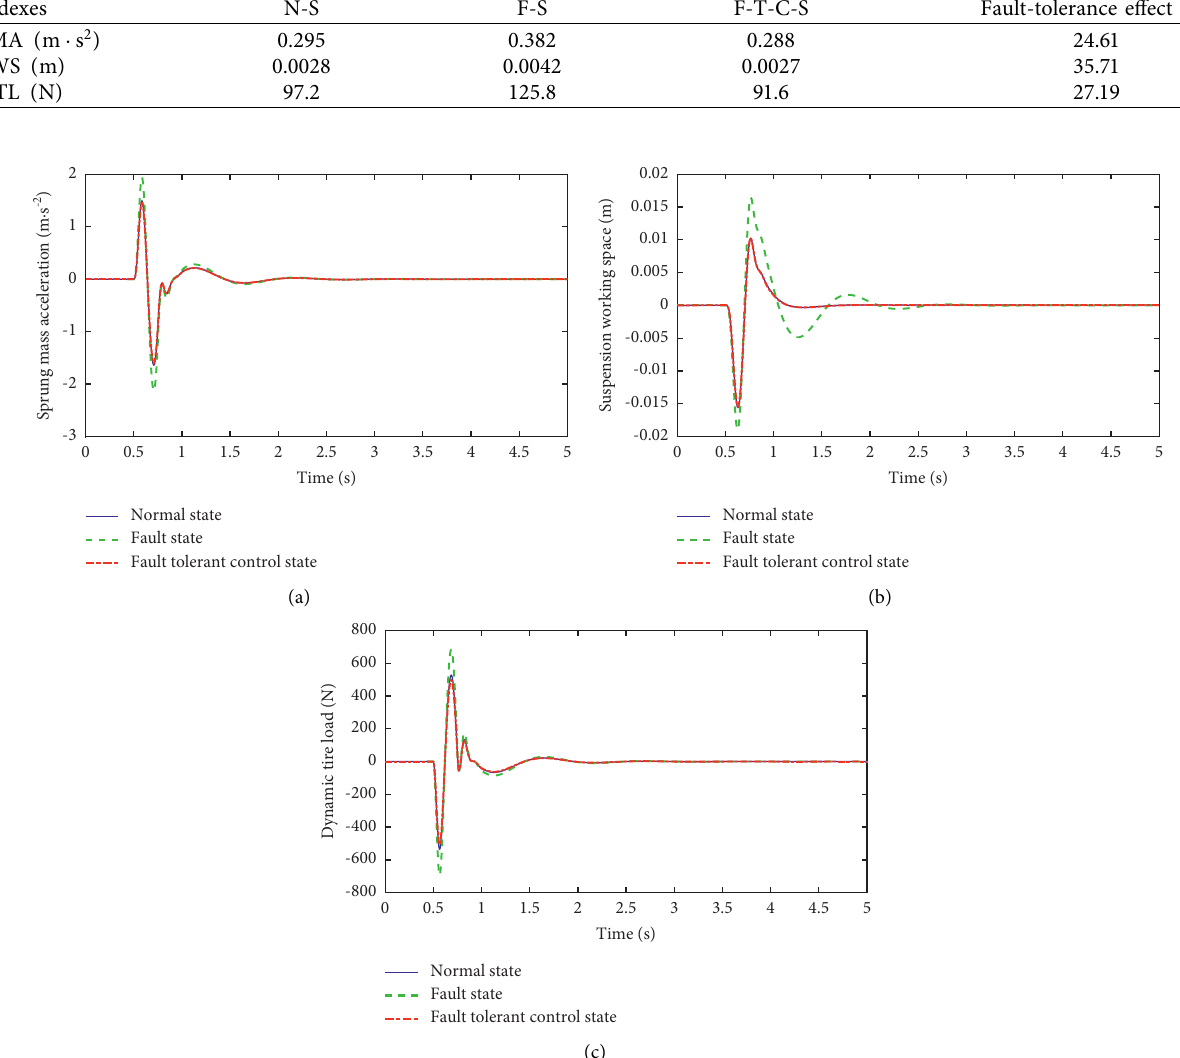
Figure 15: Comparison chart of suspension performance under bumped road. (a) Time-domain responses of sprung mass acceleration under bumped road. (b) Time-domain responses of suspension working space under bumped road. (c) Time-domain responses of dynamic tire load under bumped